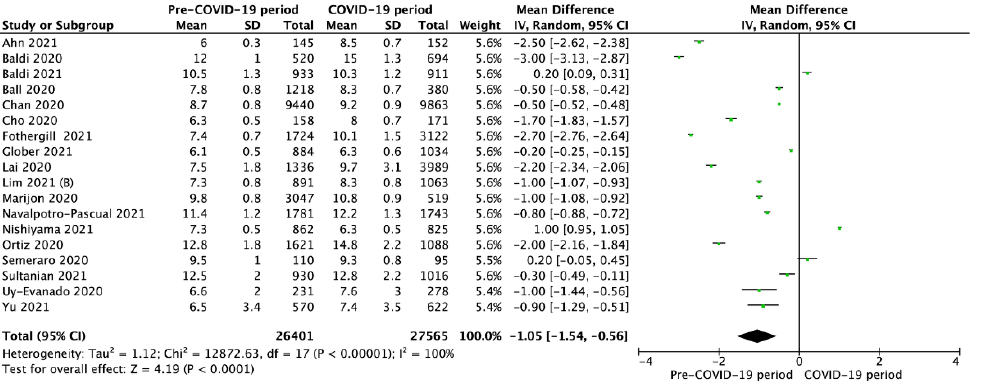
Figure 2. Forest plot of time to Emergency Medical Service arrival in pre- vs. intra-COVID-19 periods. The center of each square represents the weighted mean differences for individual trials, and the corresponding horizontal line stands for a 95% confidence interval. The diamonds represent pooled results. Legend: CI = confidence interval; MD = mean difference.